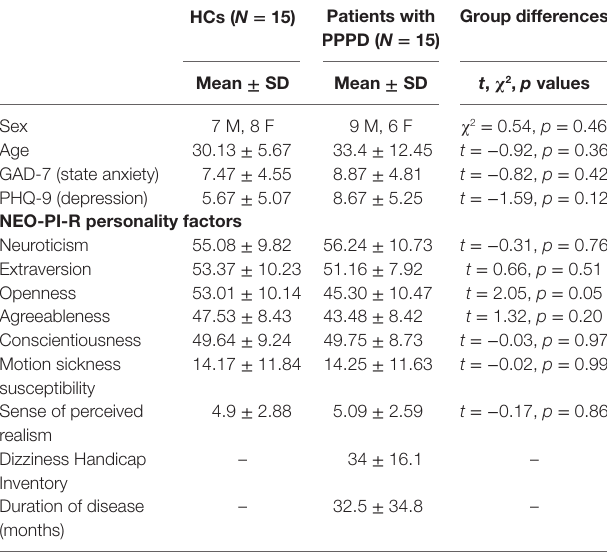
TaBle 1 | Demographic and clinical characteristics in patients with PPPD and healthy controls